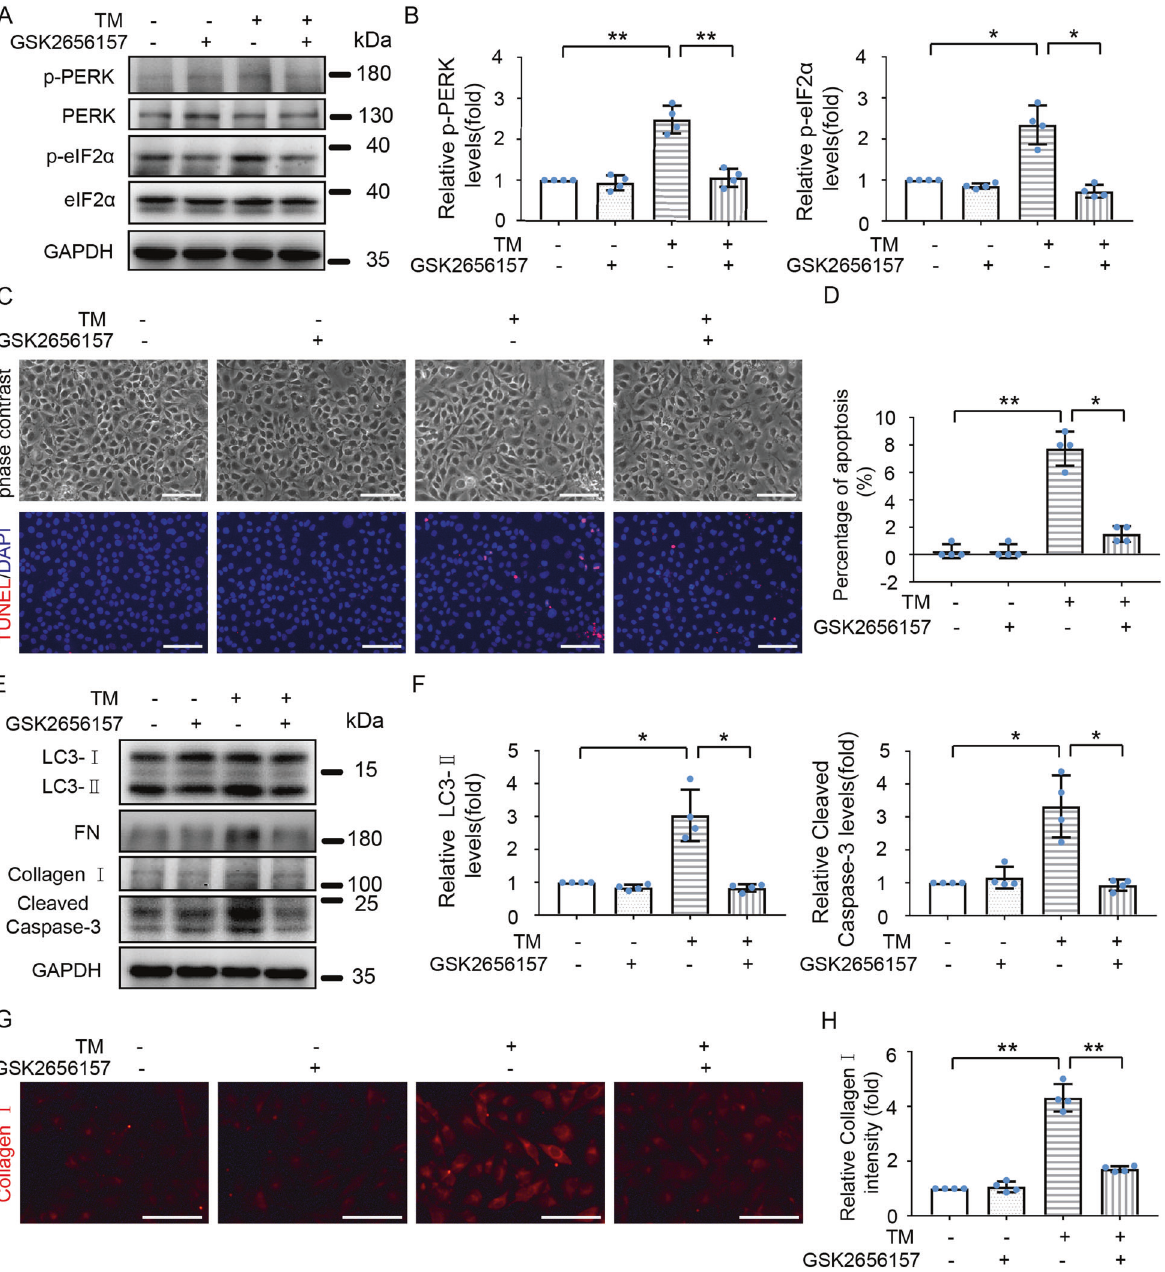
Fig. 4 Inhibition of PERK mitigates autophagy, fi brosis, and apoptosis during TM treatment of HK-2 cells. HK-2 cells were treated with or without TM (100 nM) in the absence or presence of 1 μ M GSK2656157 for 24 h. A Cell lysates were analyzed for p-PERK, PERK, p-eIF2 α , eIF2 α , and GAPDH by Immunoblot analysis; B Densitometric analysis of p-PERK and p-eIF2 α band signals. C Representative phase-contrast and TUNEL staining images of HK-2 cells. Scale bar = 100 μ m. D Counting of TUNEL staining positive cells. E Cell lysates were analyzed for LC3-II, FN, Collagen I, cleaved Caspase-3, and GAPDH by Immunoblot. F Densitometric analysis of LC3-II and cleaved Caspase-3 intensity. G Representative images of Collagen I immuno fl uorescence. Scale Bar = 100 μ m. H Quantitative analysis of Collagen I immuno fl uorescence. Data are expressed as mean ± SD. n = 4. * p < 0.05, ** p < (Fig. 1D – F). Consistently, a low concentration of TM also induced fi brotic change in both human and mouse proximal tubular cells in vitro (Fig. S3 and S4C – E). However, relatively high doses of TM were lethal to mice and caused apoptosis in cultured renal tubular cells (Fig. S1 and S3A – C). These results support the concept that the severity of ER stress is critical in determining whether cells undergo fi brotic change or commit to cell death, and moreover these fi ndings provided further evidence supporting a critical role of ER stress in the development of TIF.